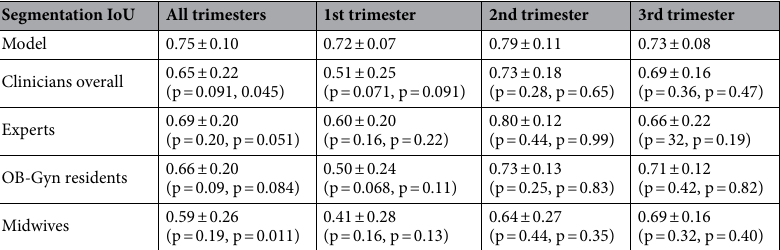
Table 3. Segmentation performance measured by IoU across trimesters for those subset cases, where images were correctly classified as containing placental tissue by the model or clinician. The IoU analysis is limited to those cases where the model or clinician correctly classifies the image as containing placental tissue, hence precisely measuring the quality of the delineated placenta in those cases where it is correctly detected. In parentheses are found the p-values resulting from (left) a 2-sample t-test for means and (right) a Levene test for variances.